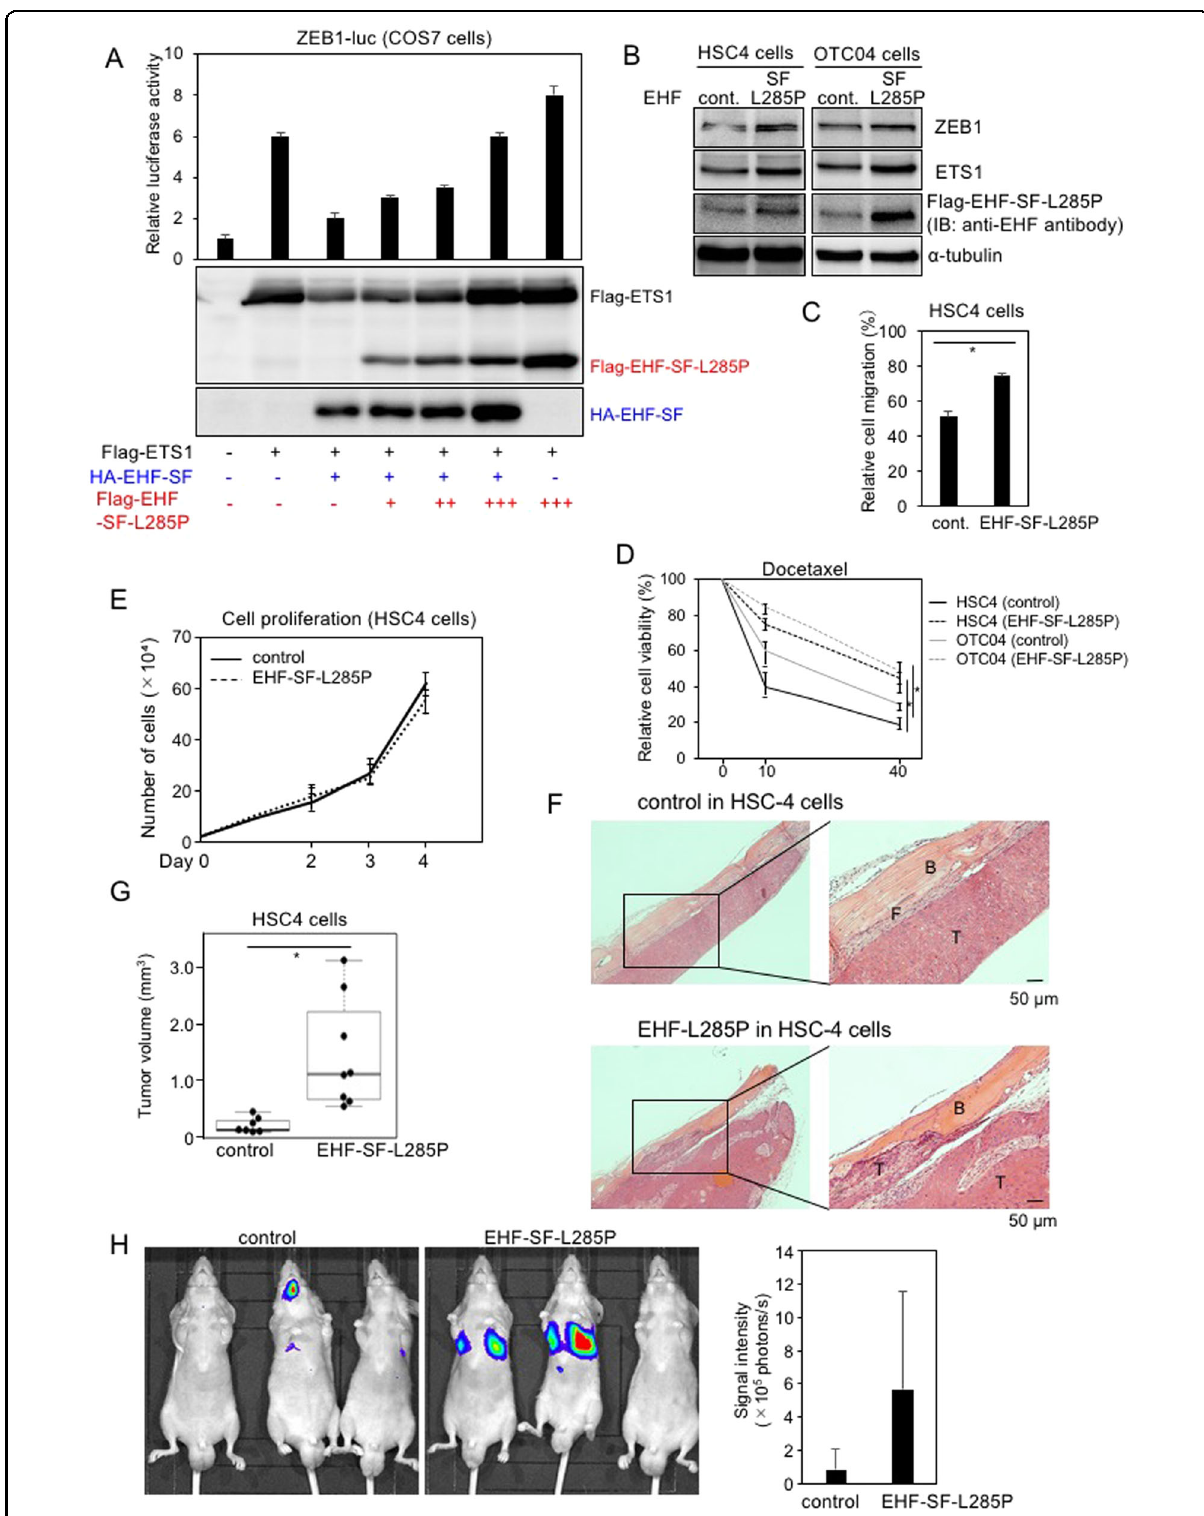
Fig. 7 (See legend on next